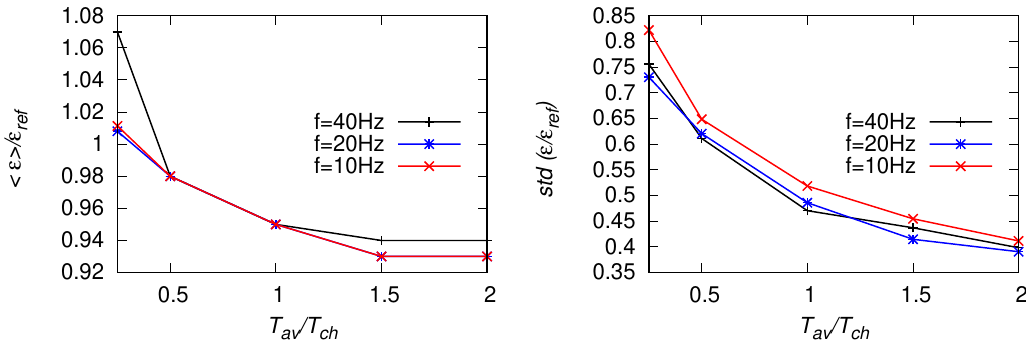
Figure 21. As in Figure 20 but for the fitting range f = [ 0.2 ÷ 5 ] Hz.